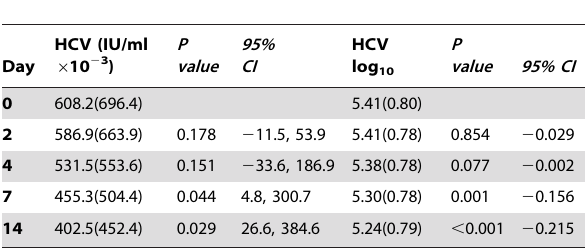
Table 3. Effects of Pioglitazone on serum HCV RNA